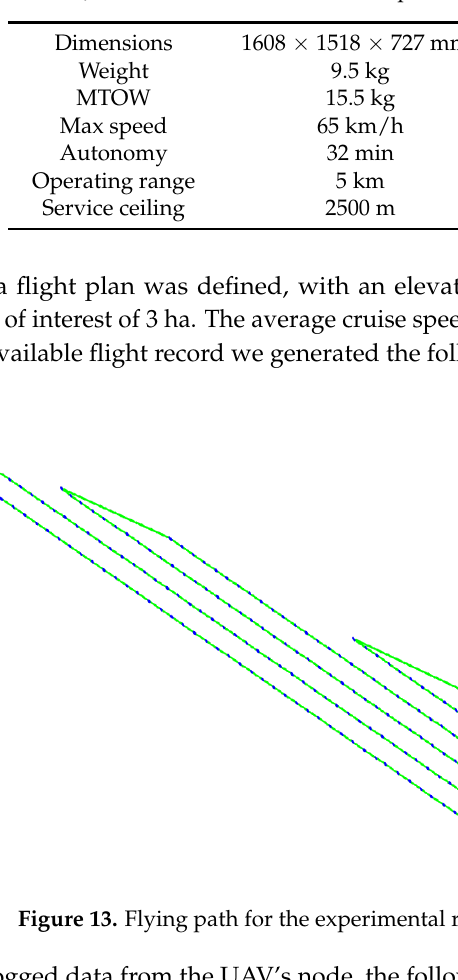
Figure 14. Sensor nodes response positions. Sensors’ estimated location over-approximated by ellipsoidal shapes are illustrated in Figure 15. For node 4.130 which is located at the edge of the monitored area, it was not possible to define an